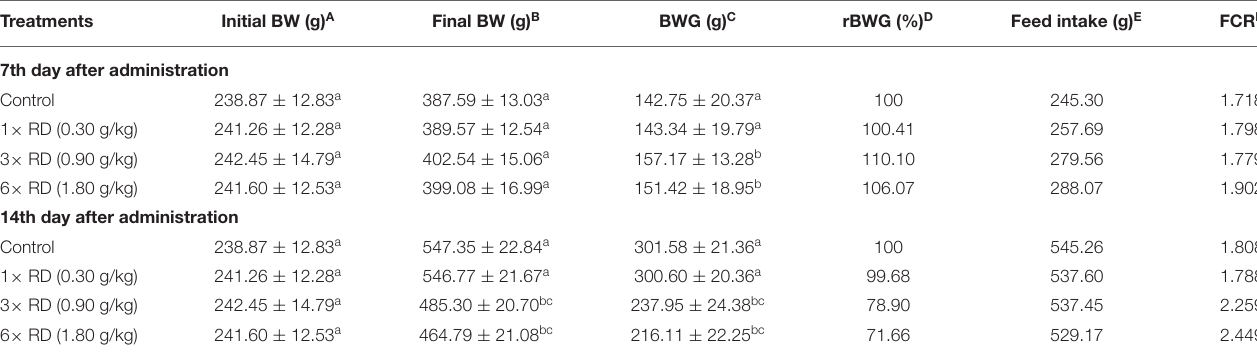
TABLE 3 | Effect of Qinghao Powder on growth performance of chicks in the safety test ( n = 10). Treatments